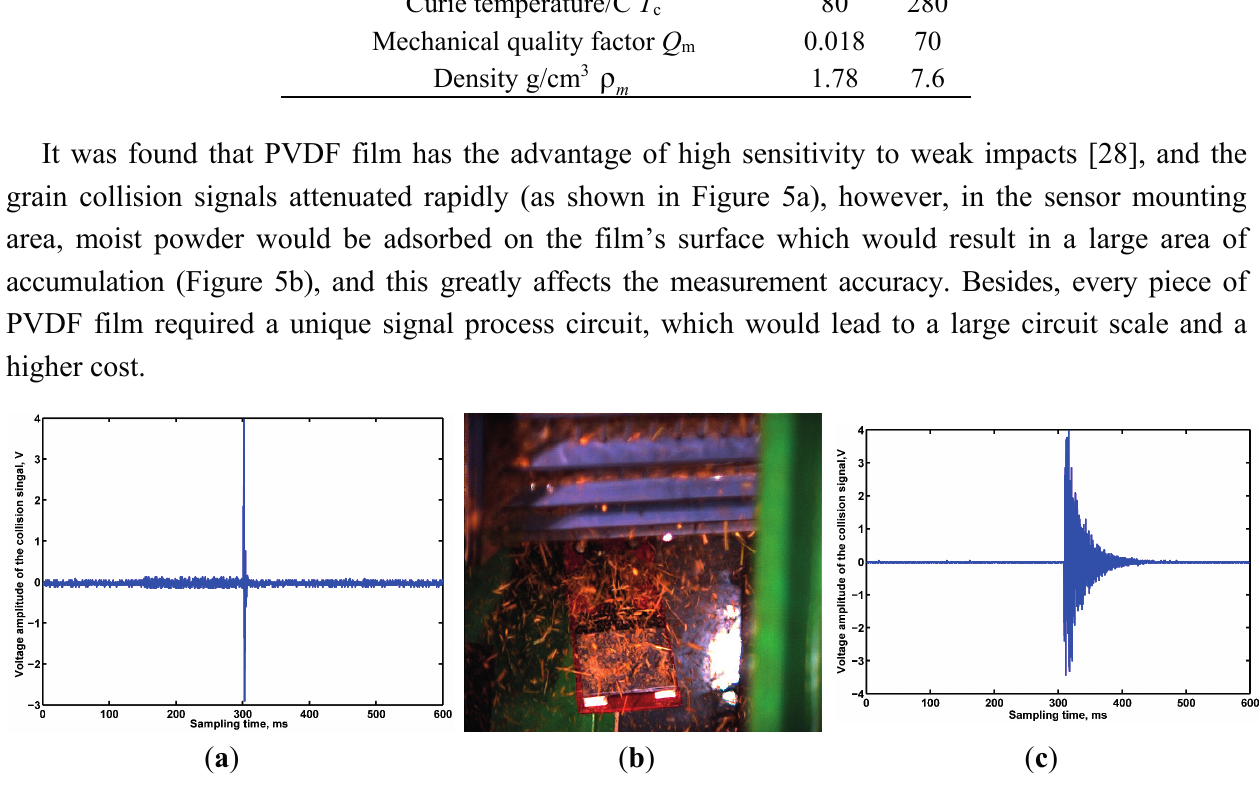
Figure 5. Grain impact sensor performance comparison experiments. ( a ) Signal diagram of grain collision PVDF films; ( b ) Working environment of the PVDF flims; ( c ) Signal diagram of grain collision YT-5L piezoelectric